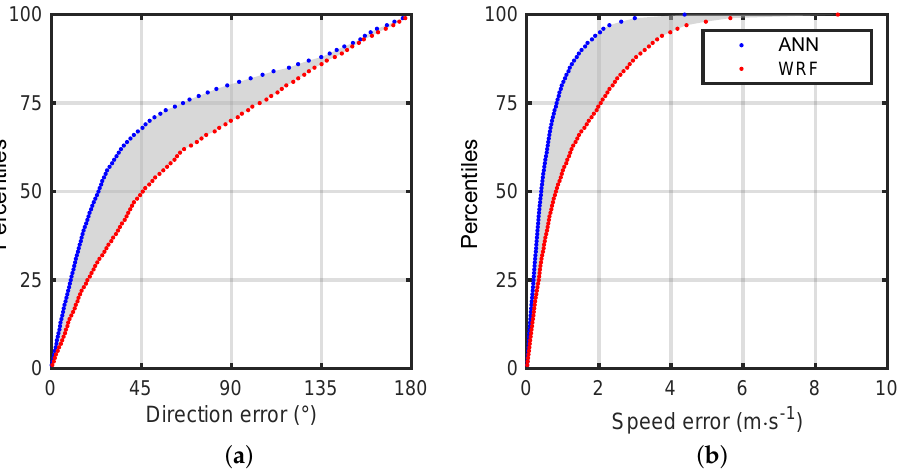
Figure 10 represents another way to visualize the gains achieved with the ANN using the cumulative distributions of errors for wind speed and direction. The gray area represents the gain resulting from the ANN. For example, the percentage of wind direction errors less than 20° represents 27% of the dataset for WRF forecasts versus 46% for the ANN. We note that the percentile values for the 45° error corresponds to the DACC reported in Table 4.